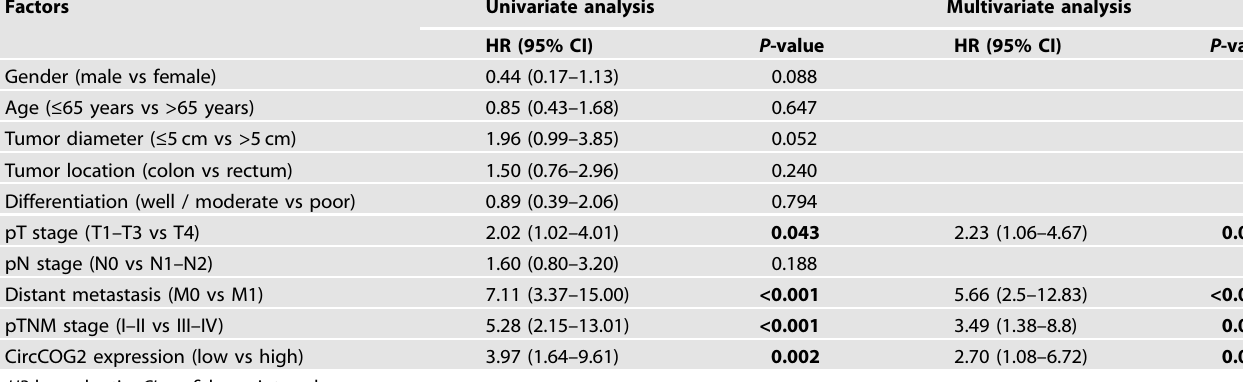
Table 2. Univariate and multivariate analysis of clinicopathologic factors for overall survival.